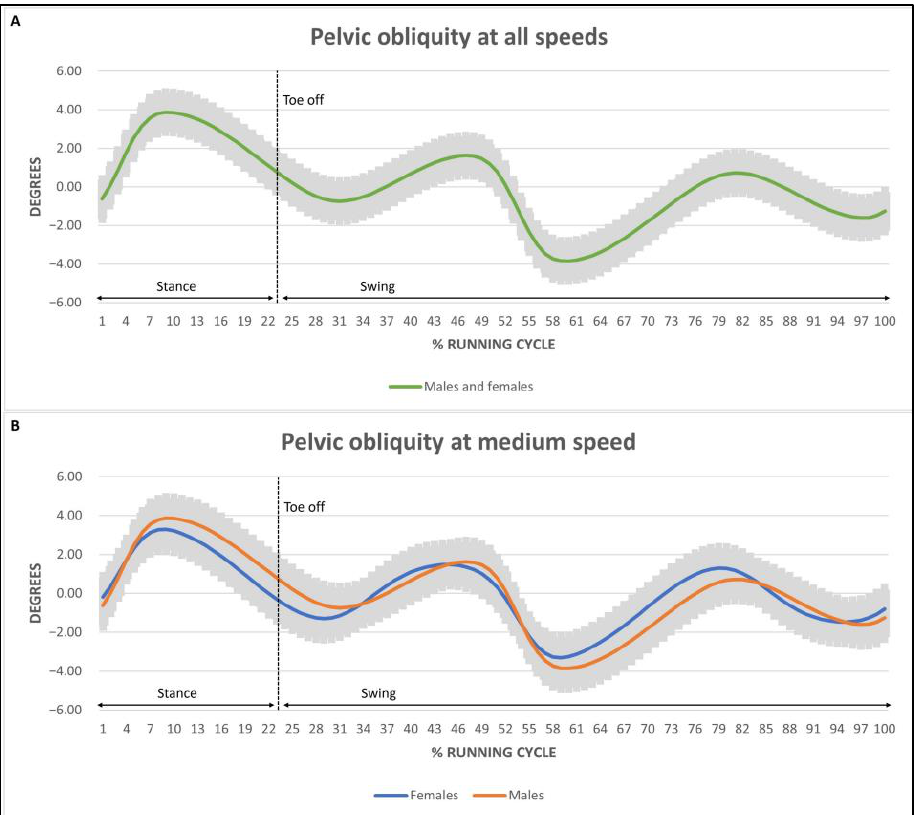
Figure 3. Pelvic obliquity trace at different speed levels with mean amplitude in males and females. ( A ) at all speed levels. ( B ) at medium speed. Negative degrees represent a caudal obliquity. Positive degrees represent an obliquity in the cranial direction.